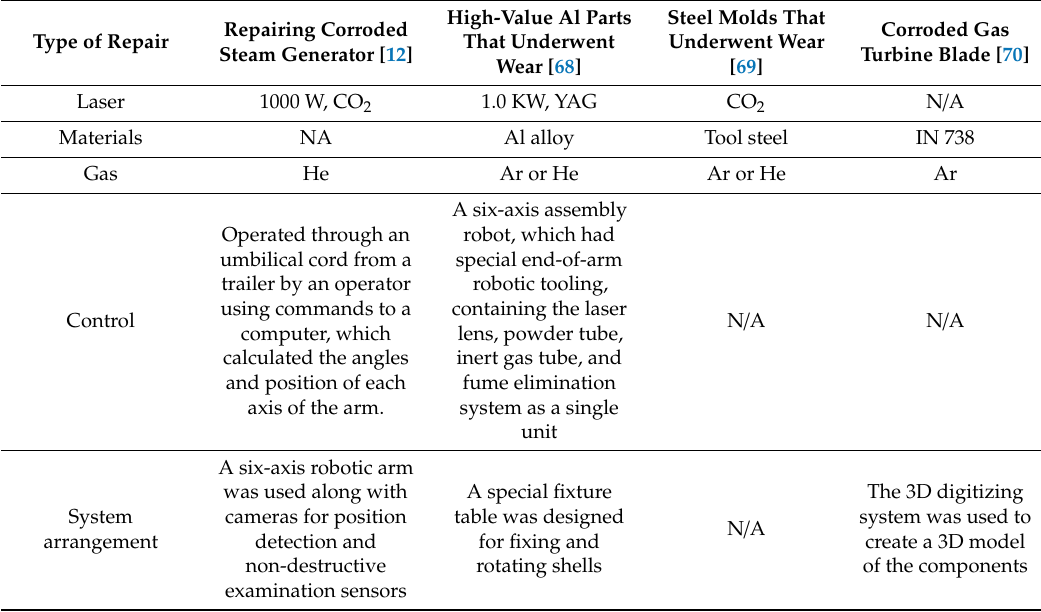
Table 2. Summary of some applications of DED as repair and dedicated systems for